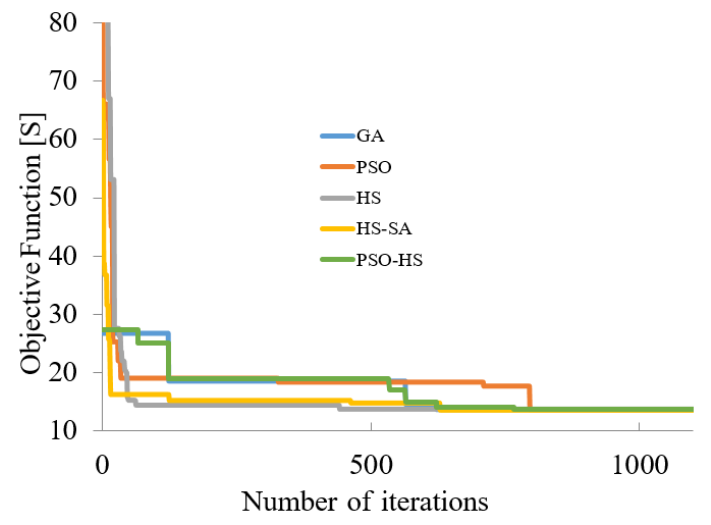
Figure 5. Convergence of different algorithms for Scenario 2.